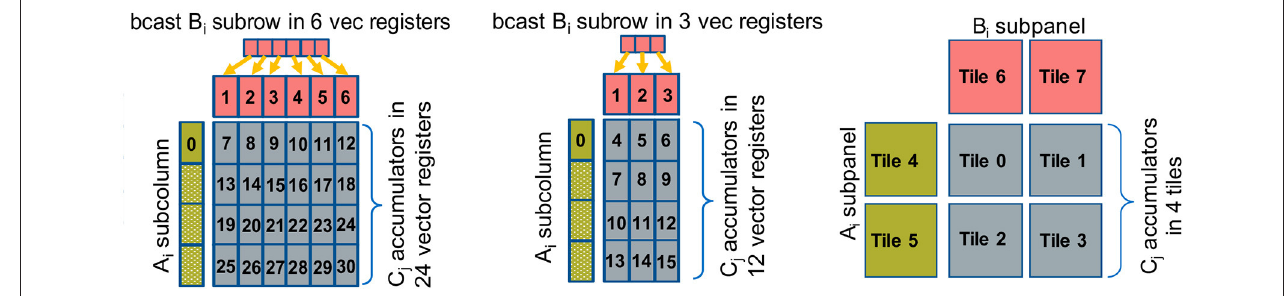
FIGURE 2 | Outer product GEMM microkernels, Left : On a platform with 32 vector registers, Middle : On a platform with 16 vector registers, Right : On a platform with 8 2D registers